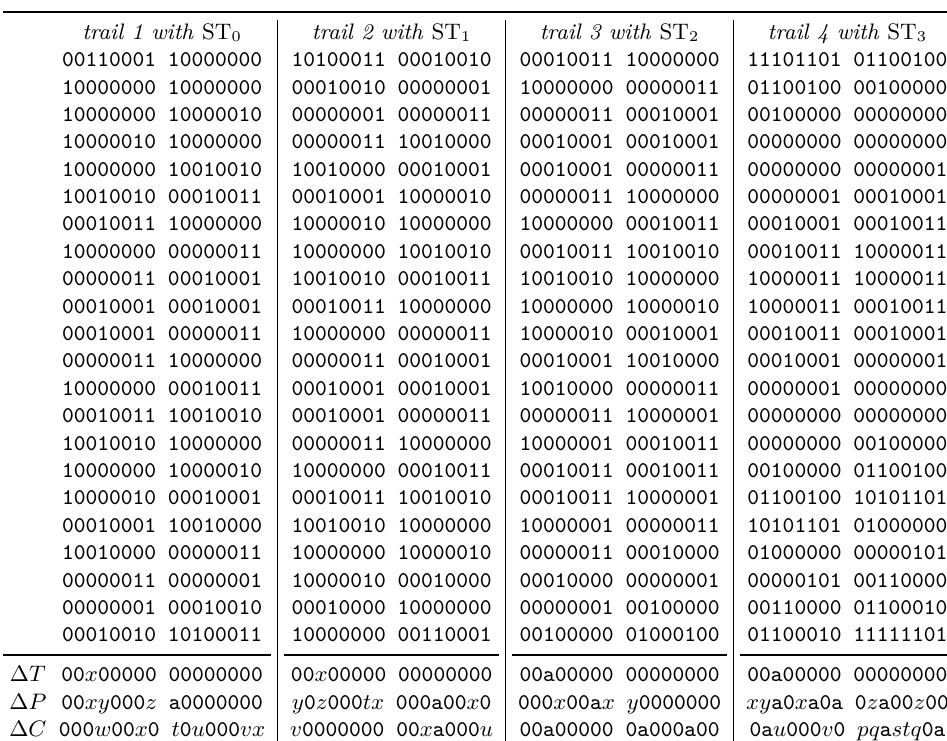
Table 5: 21-round related-tweak differentials with the highest EDP within the differentials of the activity patterns with the minimum (or close to the minimum) number of active